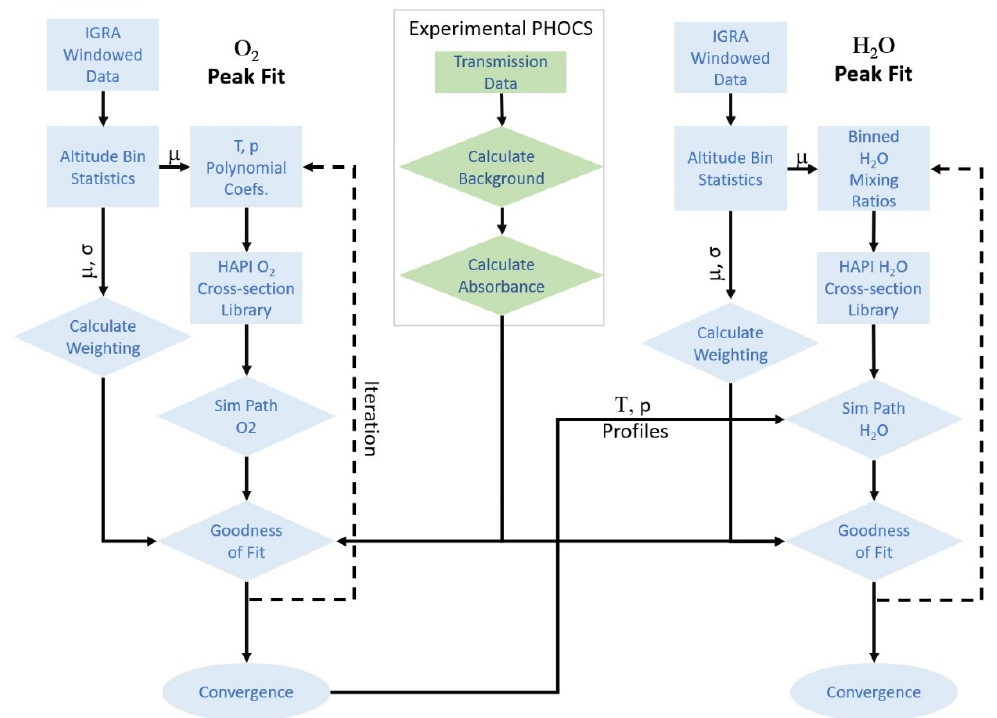
Figure 1. An illustration of the RS and PHOCS data extraction and analysis method. The PHOCS instrument stores raw heterodyne power as well as meta data for a given measurement. From this raw data, a background spectrum is calculated from spectral points removed from absorption features, and an absorption spectrum is generated. Informed by the meta data, IGRA data is collected from nearby stations, sorted into altitude bins, and statistical calculations for that windowed set are calculated. Polynomial fits of temperature and pressure are performed from the mean of each bin. Spectra for the atmospheric column are then simulated by calculating contributions from each 100 m path along this path by calling spectral cross sections from pre-calculated libraries. Weighted residuals between modeled and experimental spectra are calculated and iterated in a Nelder-Mead algorithm until convergence.